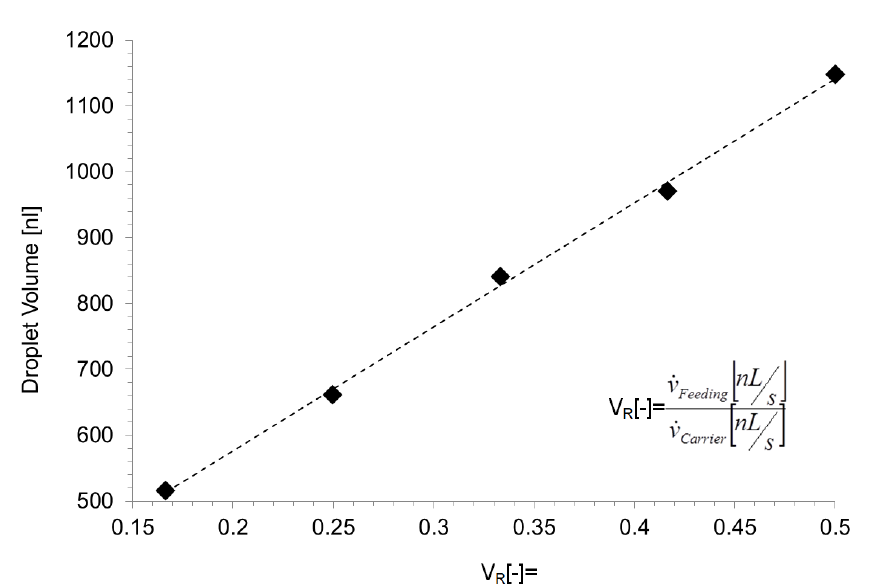
Figure 4. Received droplet volumes for various ratios between feeding- and continuous-phase flowrates V R . Feeding-liquid: (dispersed phase), 20 mM aqueous Cochenille Red A and continuous phase: Novec 7500, 0.1 wt% Picosurf. The data received for a total flow rate range of 250–2000 nL/s.